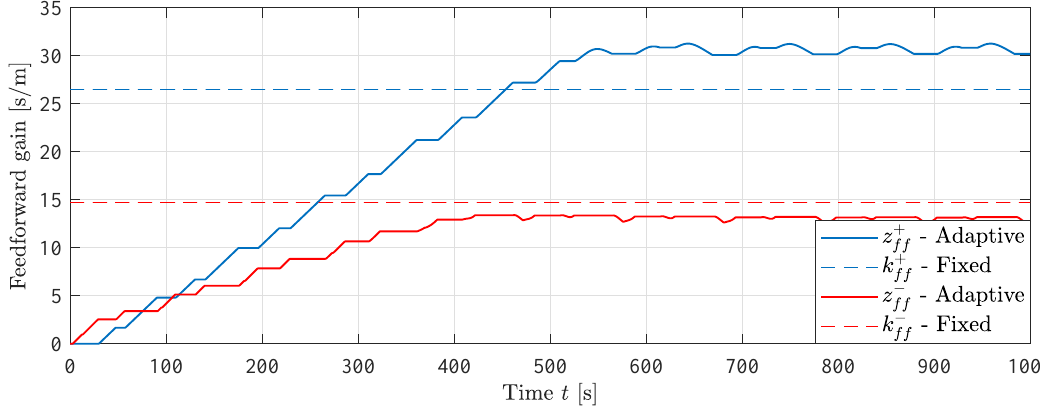
Figure 26. Feedforward states during sign-sign feedforward experiment, γ = 0.1 m − 1 .